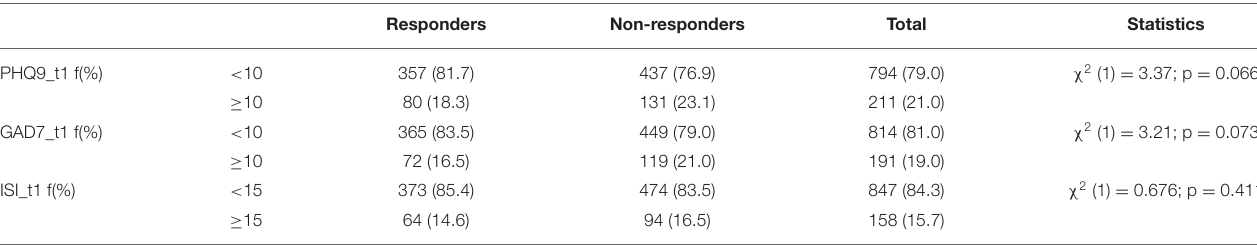
TABLE 5 | Number of participants exceeding the cut-off score for moderate depression/anxiety/insomnia measured during the lockdown (t1) in responders ( n = 437) compared to nonresponders ( n =